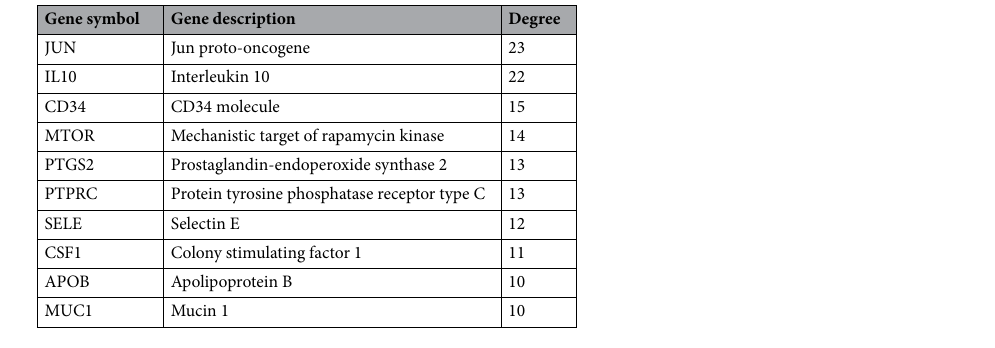
Table 1. Top ten hub genes with higher degree of